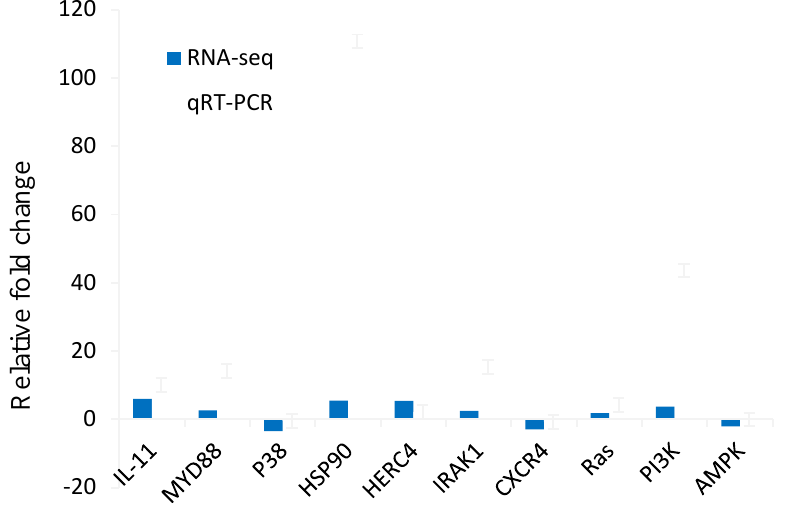
Figure 8. Comparison of relative fold changes between RNA-seq and qRT-PCR results.